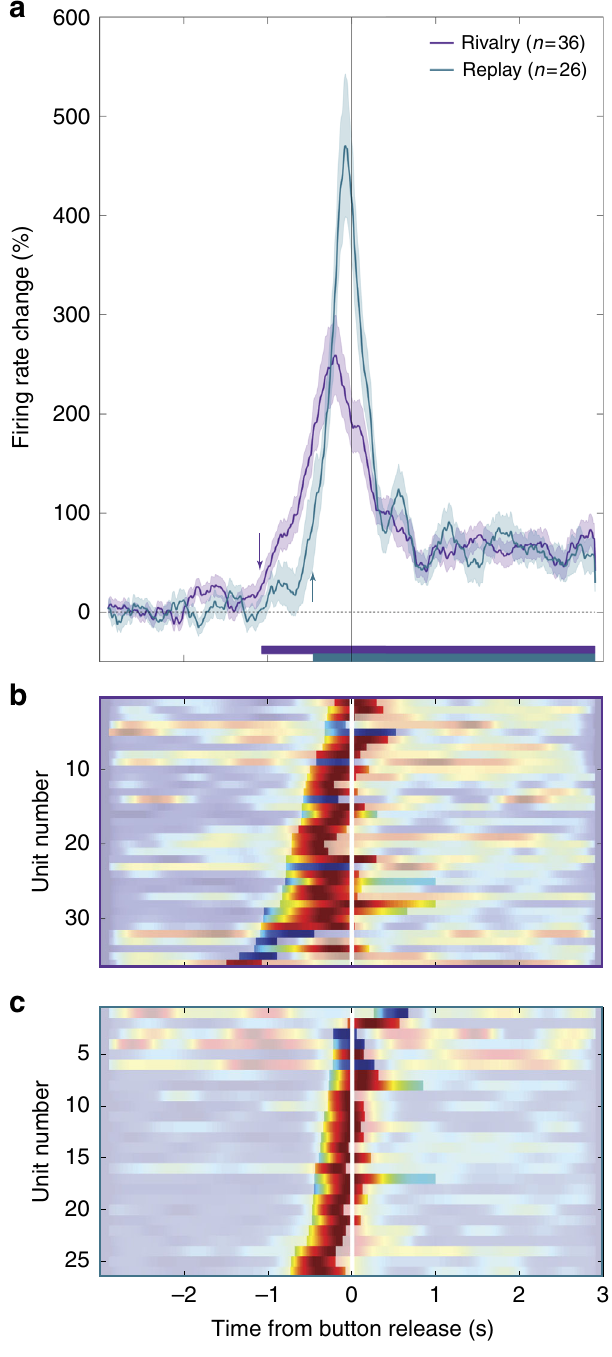
Fig. 4 MTL population-level activity started earlier during rivalry than during replay. a FR percent change (mean ± SE) around the report of perceptual transition onset to the preferred image is averaged across all MTL rivalry-active (purple; n = 36) and replay-active traces (cyan; n = 26). Traces with signi fi cant decrease below baseline FR ( n = 8 rivalry-active and n = 4 replay-active traces; see bluish highlighted periods in ( b ) and ( c )) were inverted to enable averaging. Thick horizontal bars denote times where population activity signi fi cantly diverged from baseline (onset of these periods marked by arrows); note the ~600 ms difference in onset between rivalry and replay. The normalized FR time courses used to create the average responses are presented in color code (dark blue = 0; dark red = 1) for all MTL rivalry-active ( b ) and replay-active ( c ) units, with periods of signi fi cance at the unit level